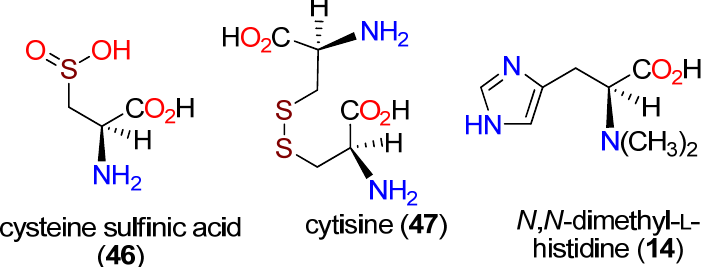
Figure 13. Structures of cysteine sulfinic acid ( 46 ), cytisine ( 47 ), and N,N-dimethyl-L-histidine ( 14 ).